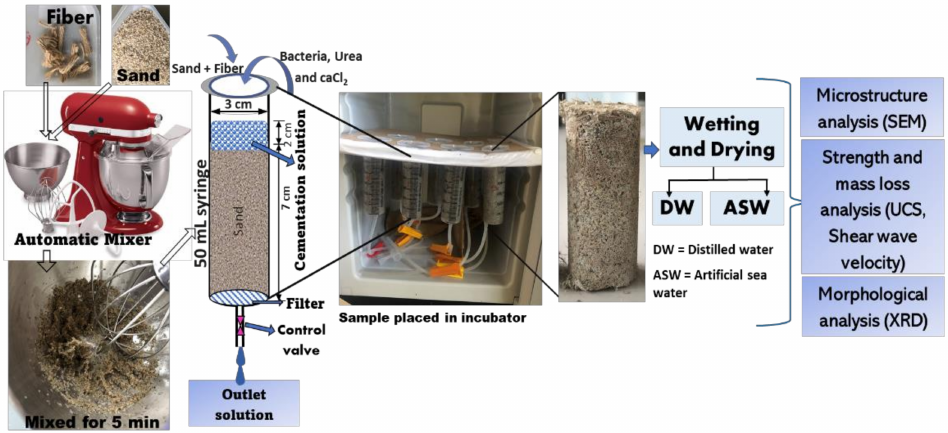
Figure 2. Experimental